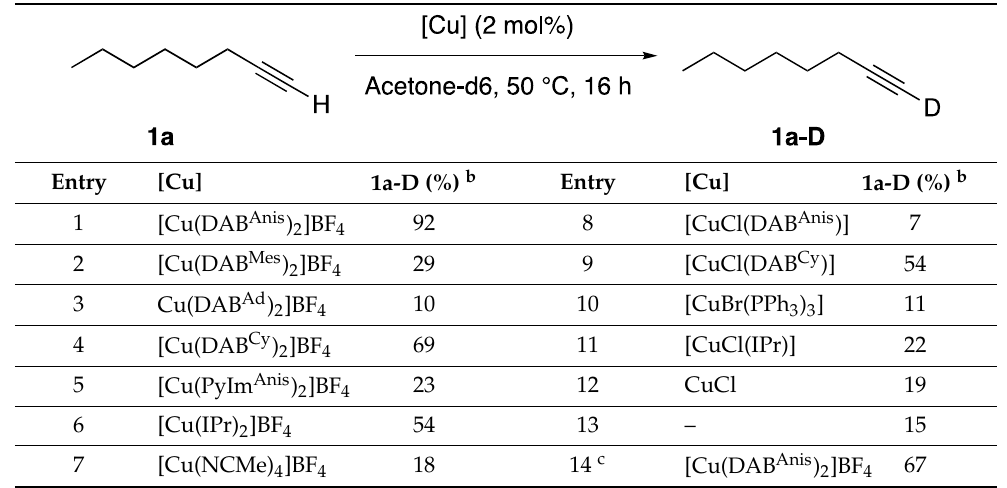
Table 1. Copper(I) catalyst screening a .